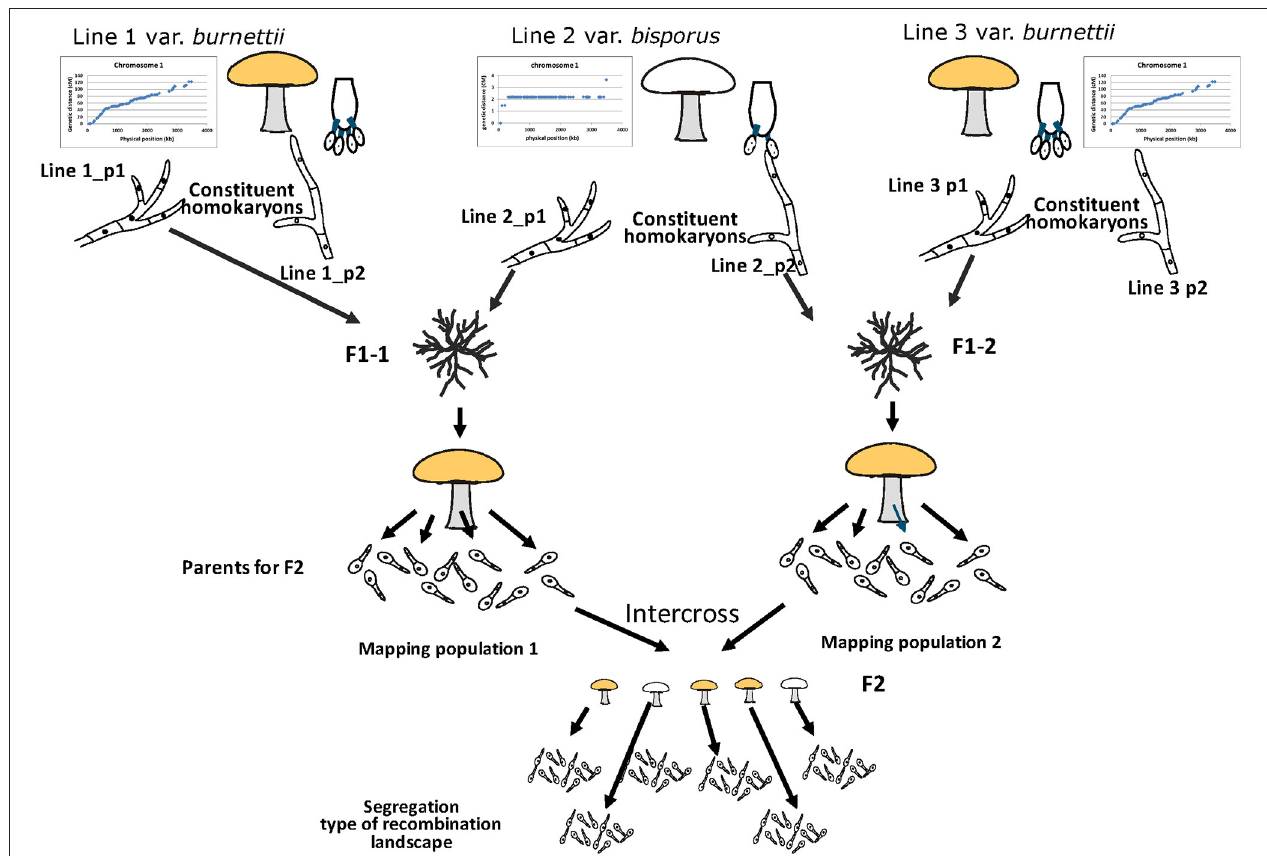
FIGURE 7 | Proposed new approach for mapping BSN and CO landscape in A. bisporus . Two genetically unrelated mapping populations are generated, both segregating for BSN and CO landscape. In this way crosses can be made between these two populations simulating an intercross within one population without the problems of homozygosity (lack of segregating markers and inbreeding depression) and with the advantage of a higher allele frequency that will strengthen the QTLs. The mushrooms of the intercross (F 2 ) can be used to assess BSN and homokaryotic offspring of this F 2 cross can be resequenced to assess precisely the CO positions without the need to isolate first the homokaryons within the single spore